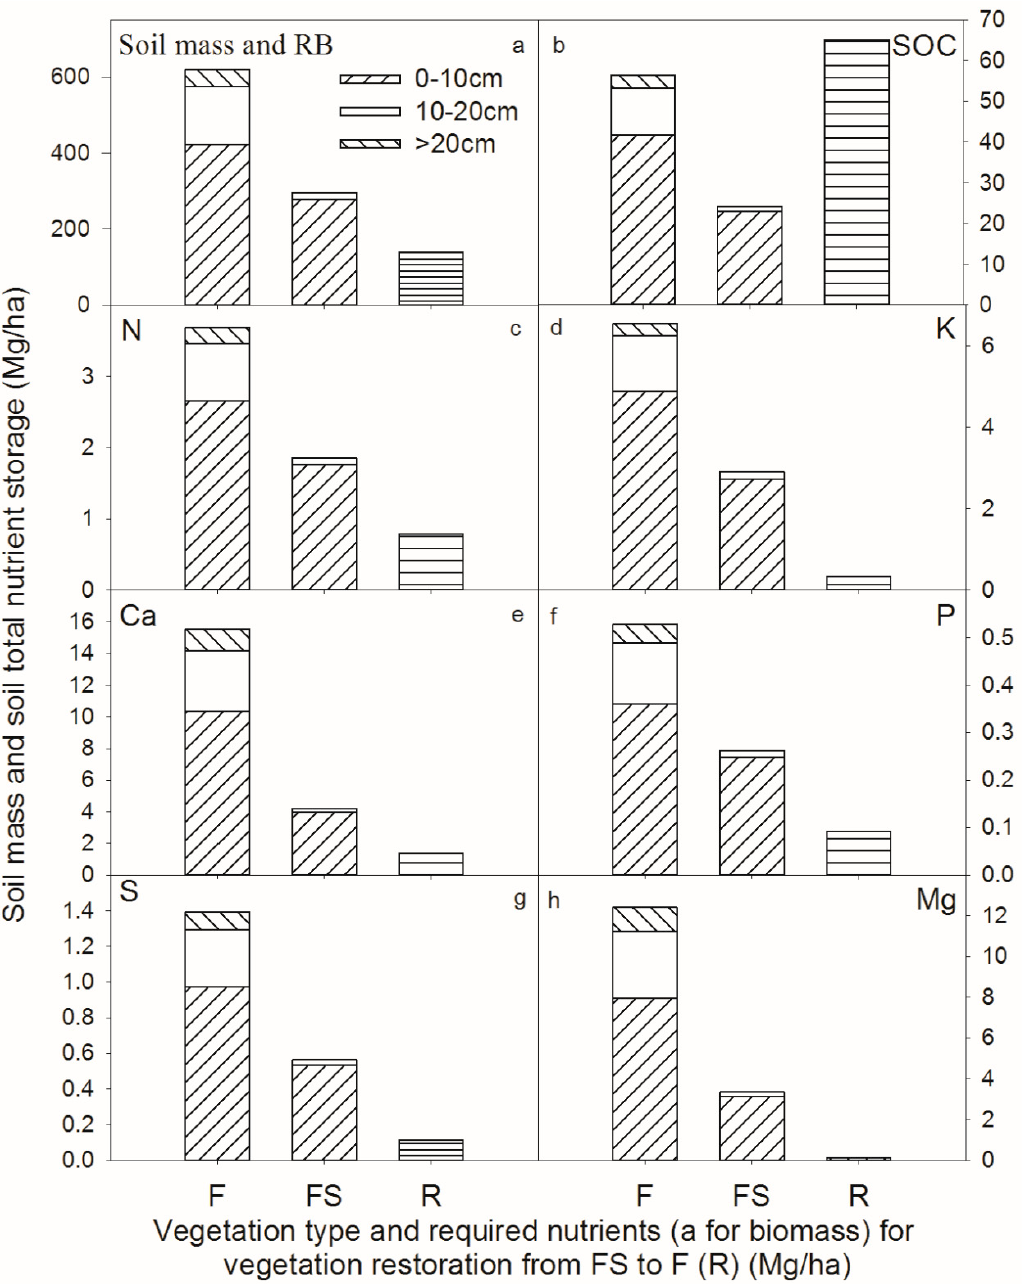
Figure 7. Soil mass and nutrient storage required for the restoration of the vegetation from FS to F.